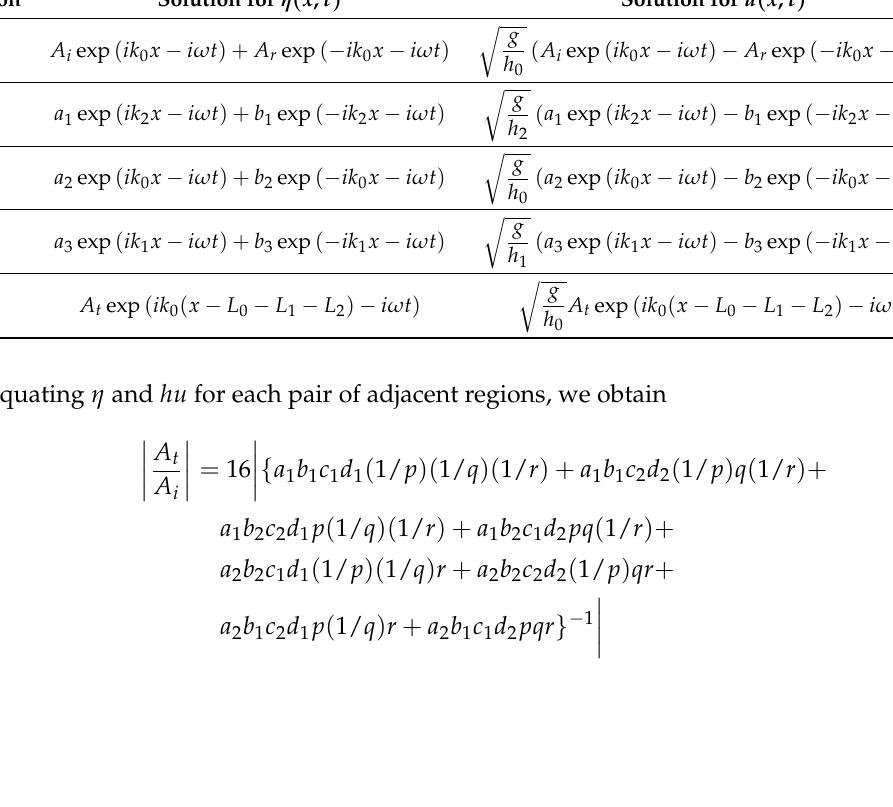
Table 2. Surface elevation η ( x , t ) and water velocity u ( x , t ) of an incident wave. Region Solution for η ( x , t ) Solution for u ( x , t